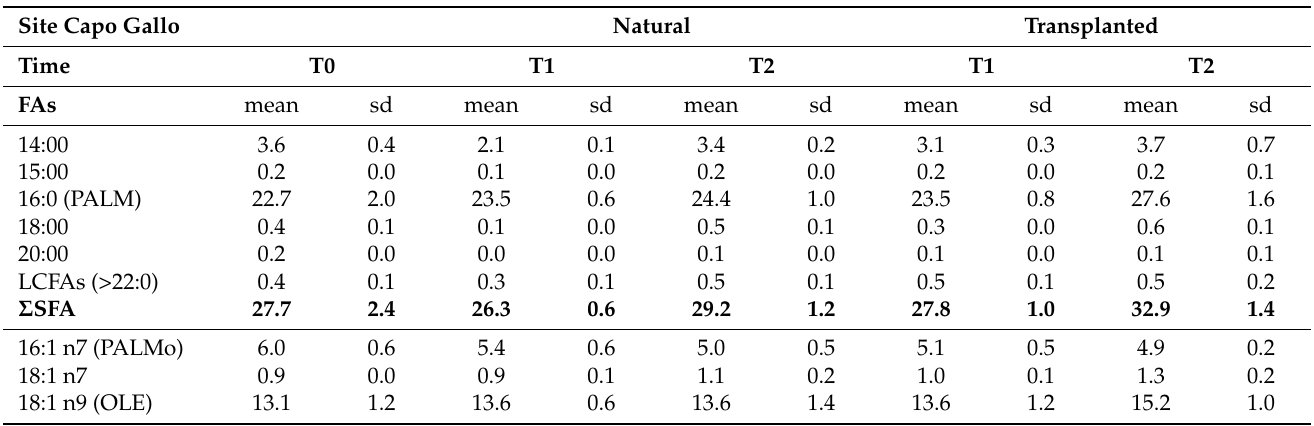
Table 2. Fatty acid relative abundance (mean ± standard deviation % of total FAs) of natural and transplanted Ericaria amentacea thalli, throughout the experiment at the Capo Gallo site. The concentration of total lipids (TL mg g − 1 ) is also reported. The sums of the different fatty acid categories and total lipids are highlighted in